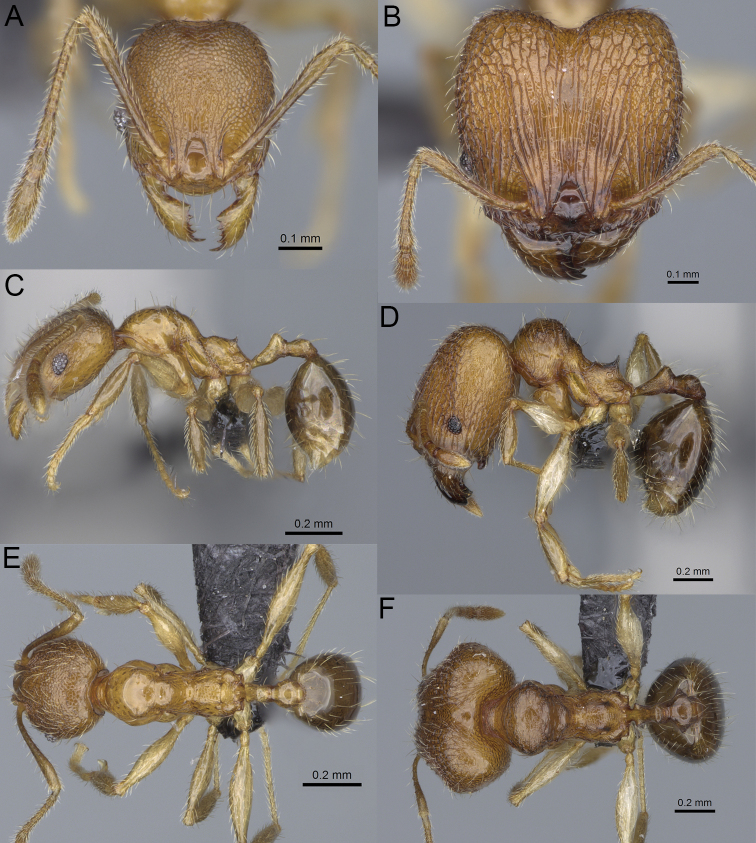
Pheidole
kely sp. nov., full-face view (A), profile (C), and dorsal view (E) of paratype minor worker (CASENT0149839) and full-face view (B), profile (D), and dorsal view (F) of holotype major worker (CASENT0235022).